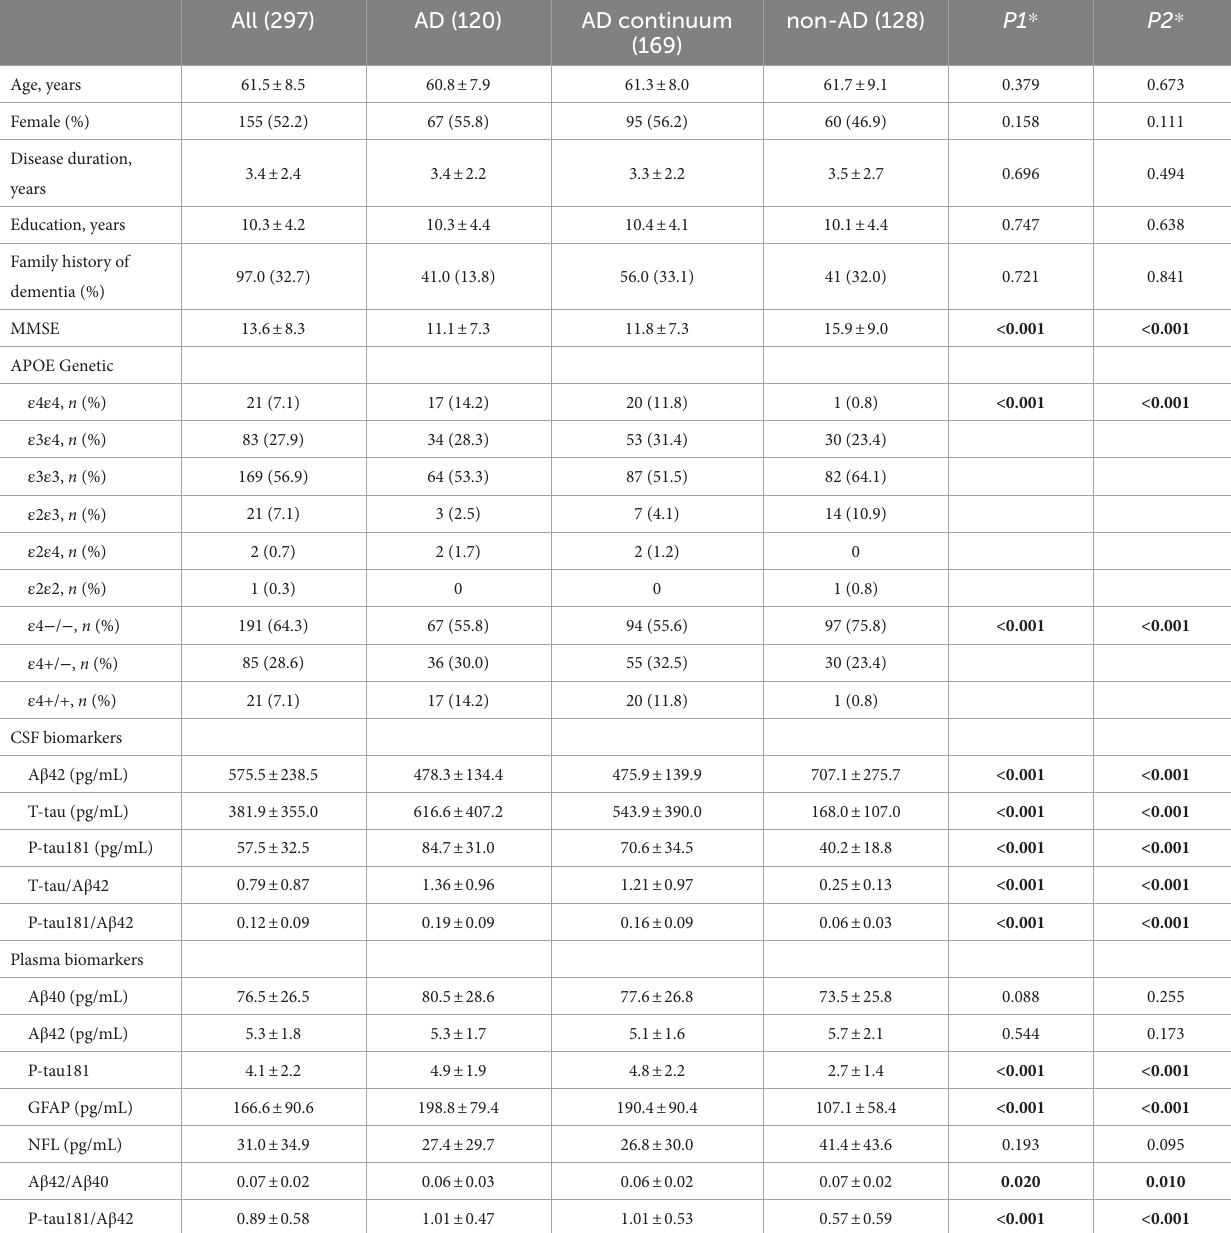
TABLE 1 Demographics, genetic data, and fluid